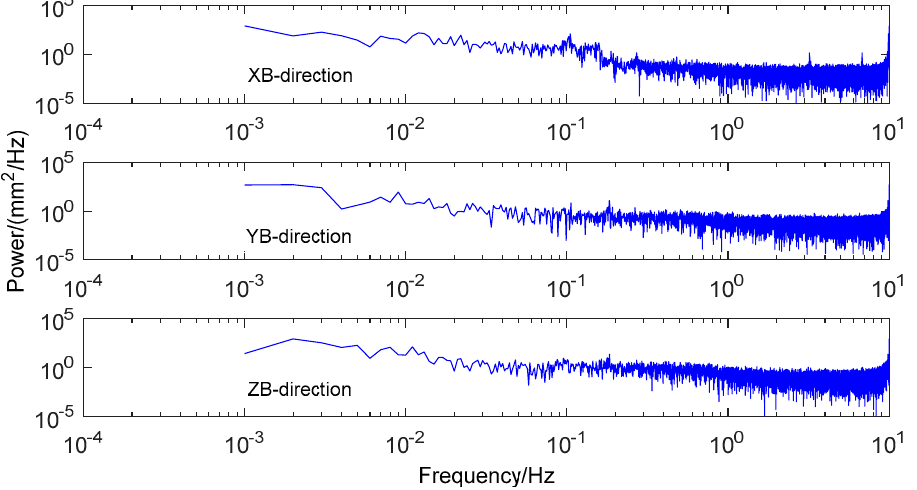
Figure 9. FFT results of shm4